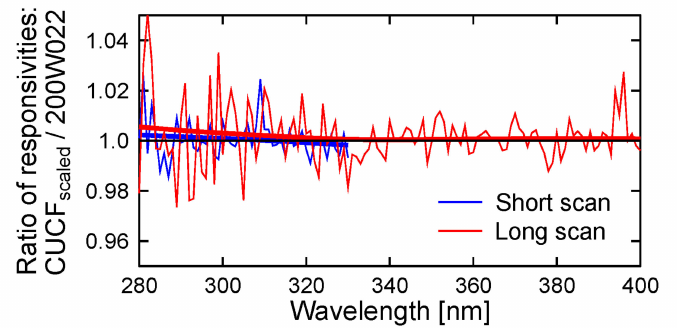
Figure A2. Ratios of responsivities of the SUV-100 spectroradiometer at San Diego, determined on 23 May 2007 with the CUCF lamps (scaled to NIST1990) and lamp 200W022 (calibrated by Optronic Laboratories, Inc (OL)). Measurements were performed with two di ff erent high-voltage (HV) settings of the SUV-100 photomultiplier tube. Blue and red lines indicate measurements at 870 and 700 V, respectively. Heavy lines indicate smoothing with an approximating